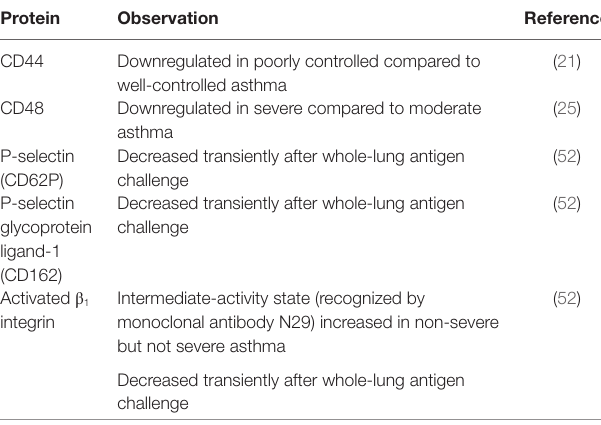
TAbLe 2 | Eosinophil surface proteins downregulated in severe or poorly controlled asthma, or transiently after whole-lung antigen